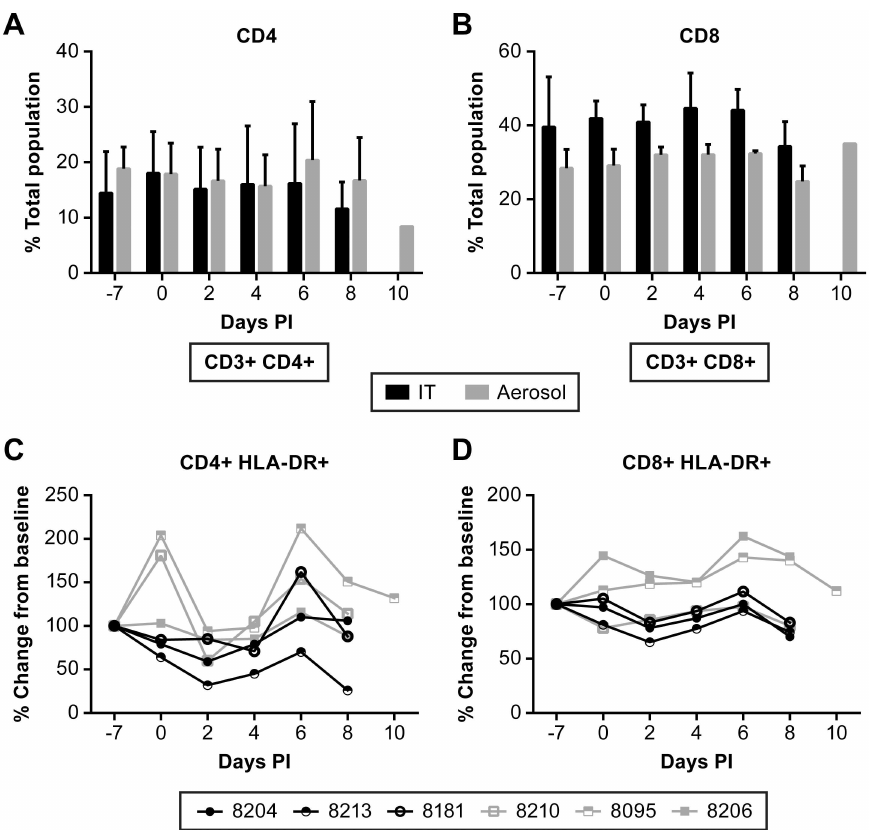
Fig 8. Evaluation of T cell responses in NiV infected AGM over the course of disease. Flow cytometric analysisof changesin CD4+ (A) and CD8+ (B) populations. Evaluationof changesin activated T cell populations was performed using HLA-DR as a marker for activationand was referenced to a pre-infection bleed. No significantchangeswere noted in activated CD4+ T cells (C), but two animalshad nominal increasedin activated CD8+ T cells (D) relative to other animals. Animalswere infected with NiV by IT (black) or aerosol (gray)